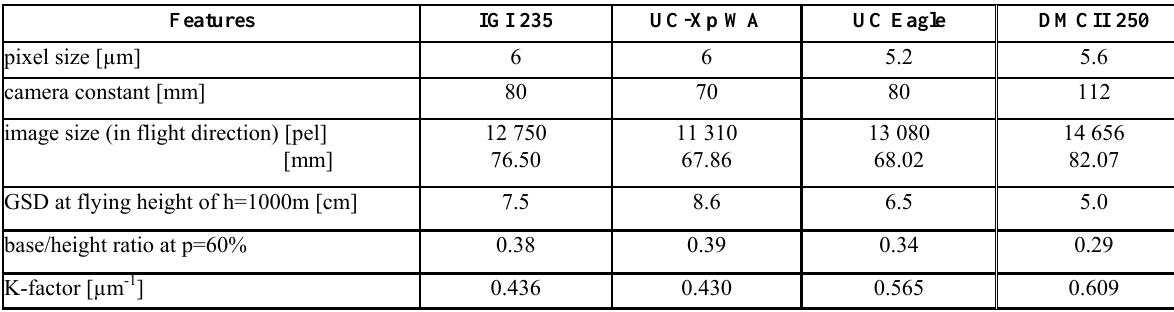
Table 1. Features of four new digital aerial